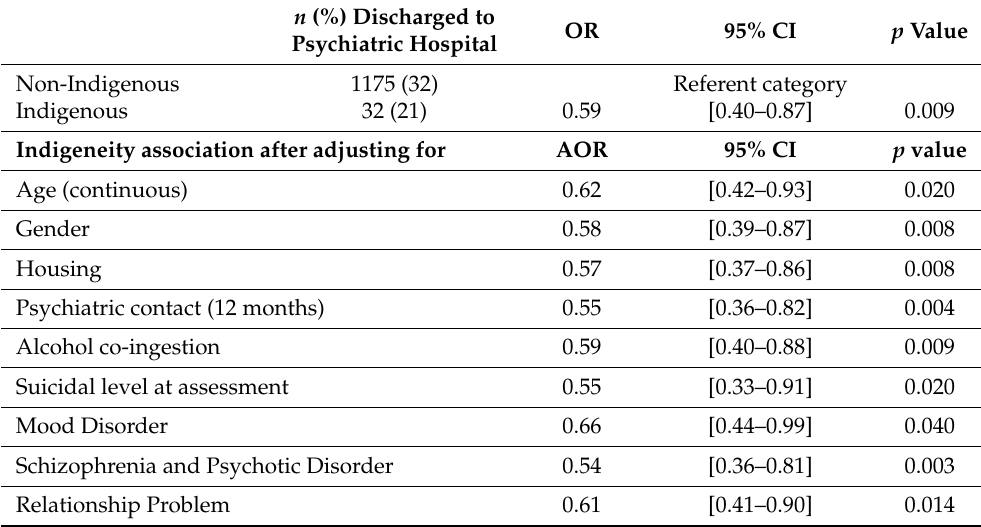
Table 2. Unadjusted and Sequentially Adjusted Estimates for Cultural Identity Predicting Discharge to Psychiatric Hospital.